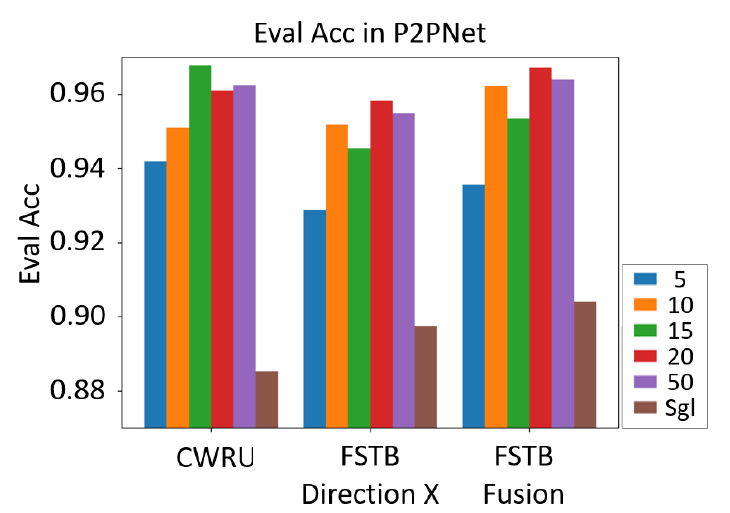
Figure 11. Evaluating accuracy of the method proposed in the peer-to-peer network with different datasets and various node numbers. Different bars represent different numbers of models in a cluster. The last “Sgl” shows only one model in a single machine intelligence